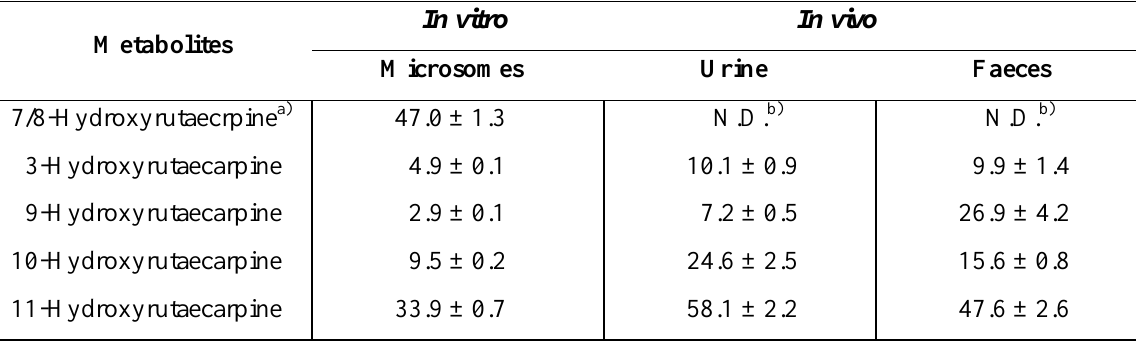
Table 8. In vitro and in vivo Phase I metabolites of